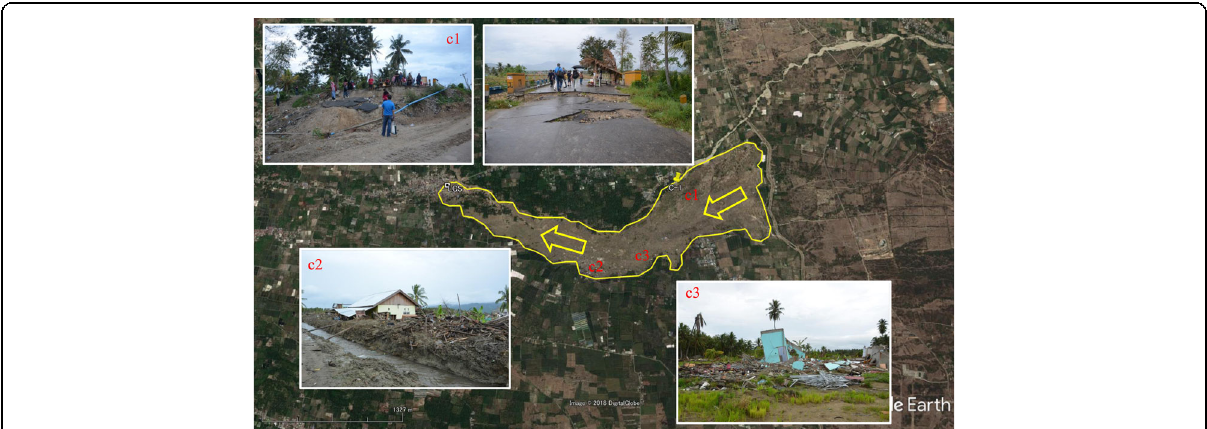
Fig. 11 Satellite photo by Google Earth and some photos of damage in Jono Oge